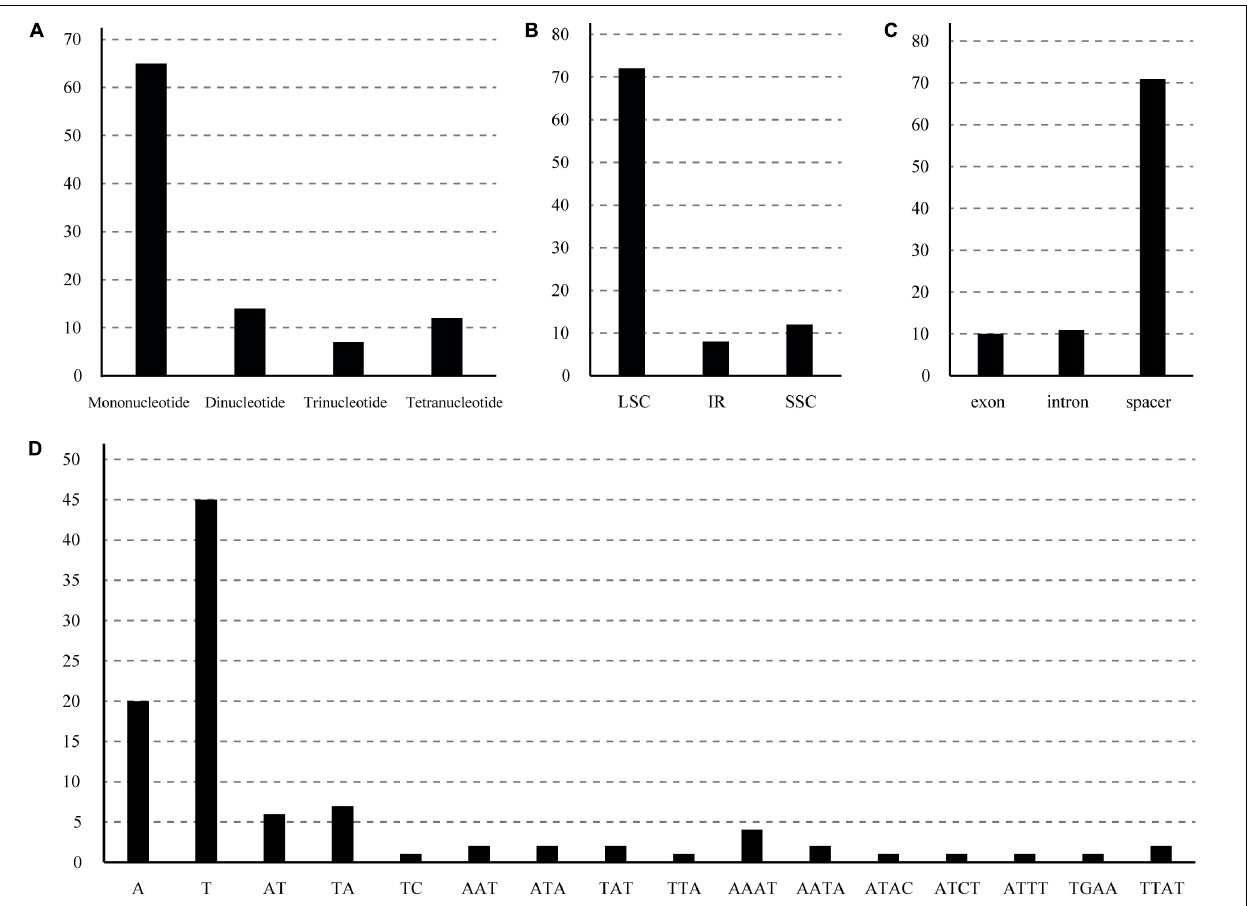
FIGURE 4 | Type and distribution of simple sequence repeats (SSRs) in B. sinensis chloroplast genomes. (A) Number of different SSR types detected by MISA. (B) Number of SSRs in the LSC, SSC, and IR regions. (C) Number of SSRs in spacers, exons, and introns. (D) Frequencies of identified SSR motifs in the different repeat